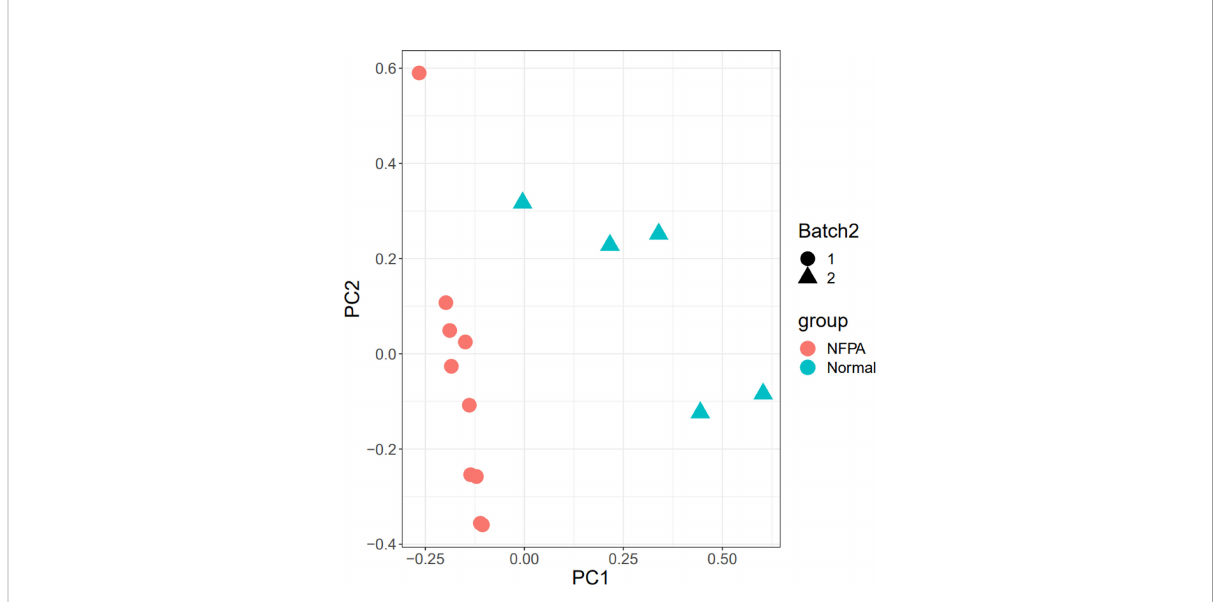
FIGURE 3 PCA plot. The Batch implies that the data includes two platforms. Also, healthy and tumor samples were divided into two